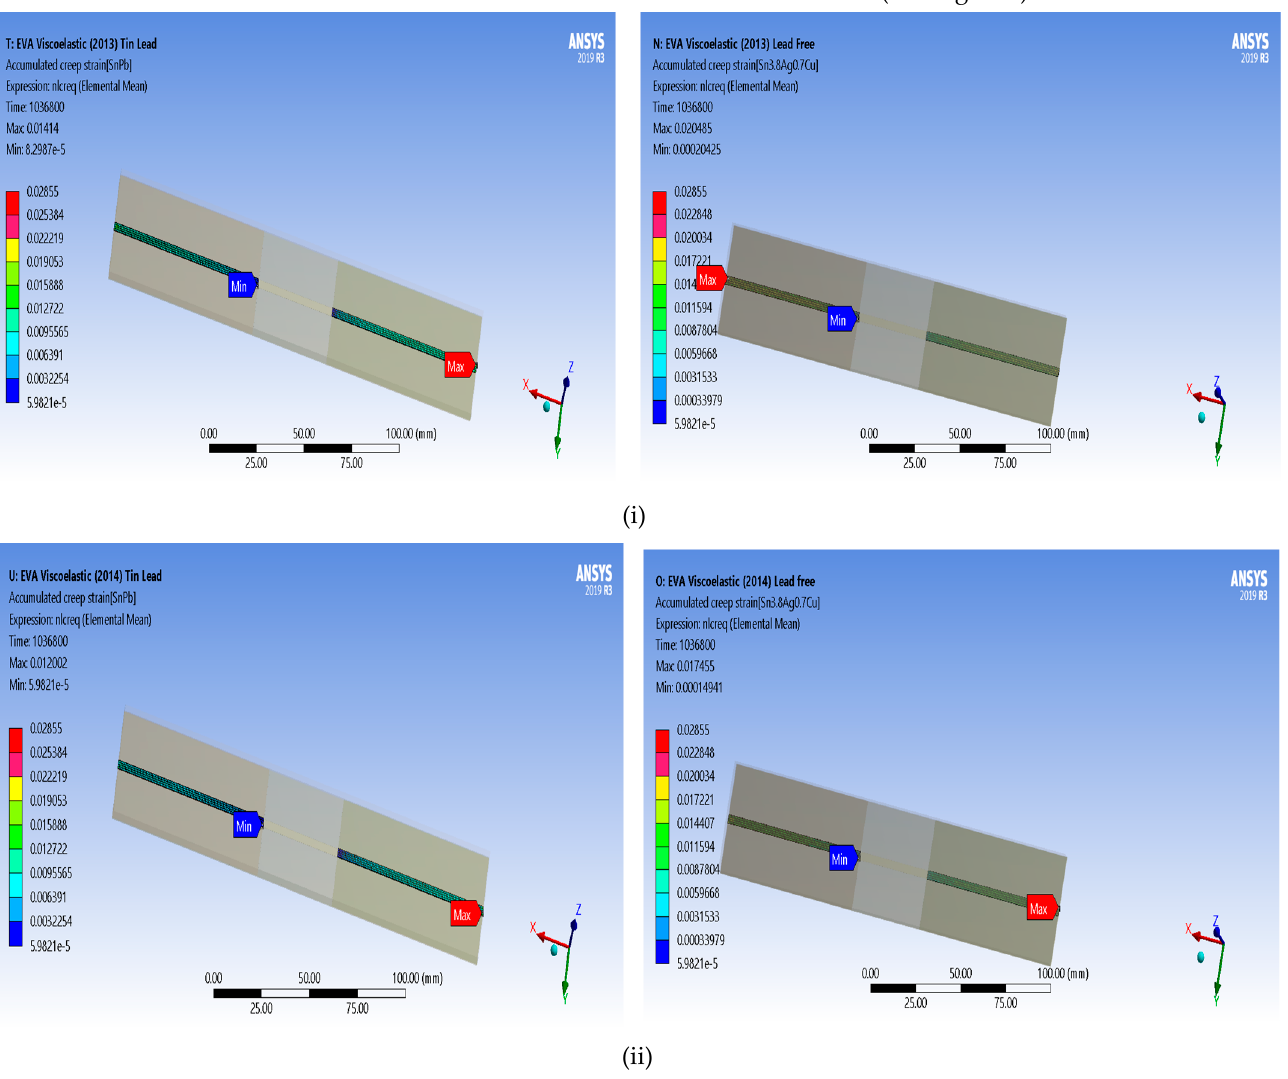
Figure 10. Accumulated creep strain damage distribution in PbSn and Pb ‐ free solder interconnec ‐ tion for: ( i ) TRA and ( ii ) 2012 thermal cycles.